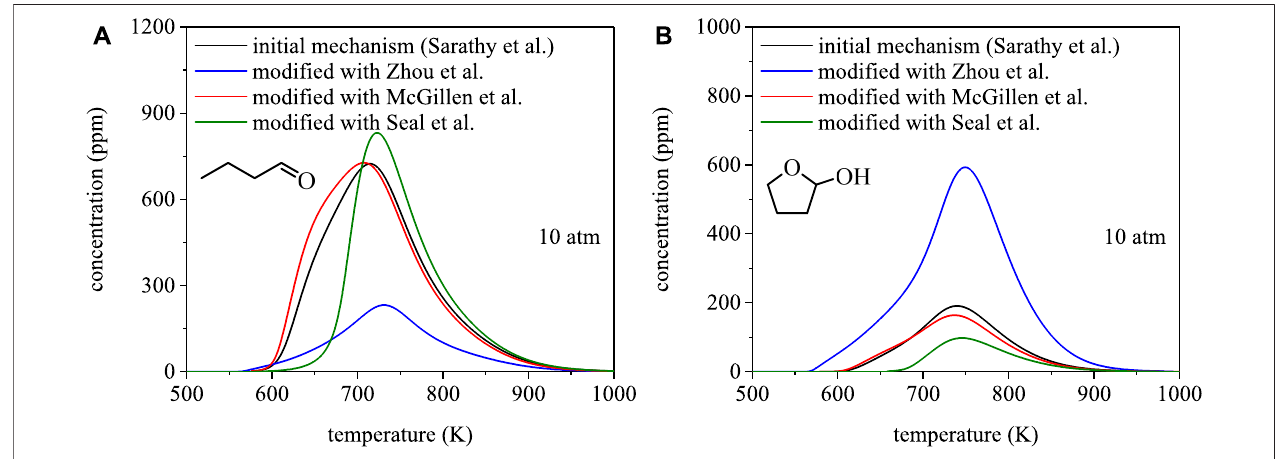
FIGURE8| Speciationsimulationsfor1-butanolusingthemechanismfromSarathyetal.(Sarathyetal.,2012)andsite-speci fi cratemodi fi cationsusingZhouetal. (Zhou et al., 2011), Seal et al. (Seal et al., 2013), McGillen et al. (McGillen et al., 2013): (A) butanal, (B) 2-hydroxytetrahydrofuran. Despite agreement between total rate coef fi cients, disagreements in predicted branching fractions can result in signi fi cantly different projections for combustion